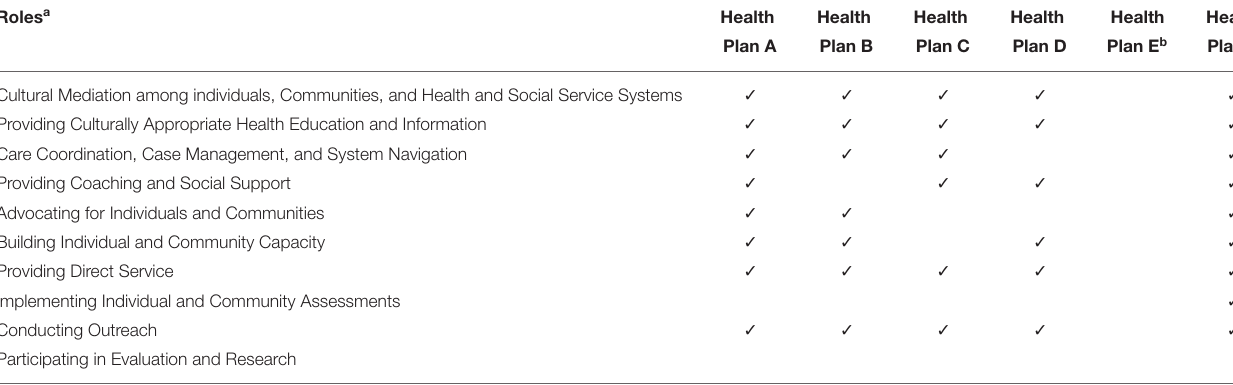
TABLE 3 | Community health worker core competencies and roles utilized within arizona medicaid-contracted health